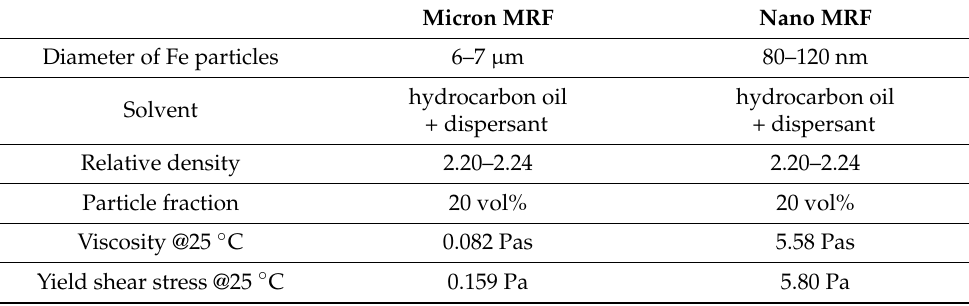
Table 4. Properties of the standard materials.